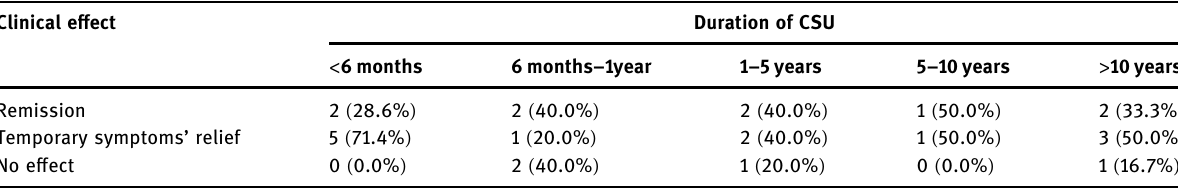
Table 6: Plasmapheresis e ff ect in group of patients for whom omalizumab was ine ff ective Clinical e ff